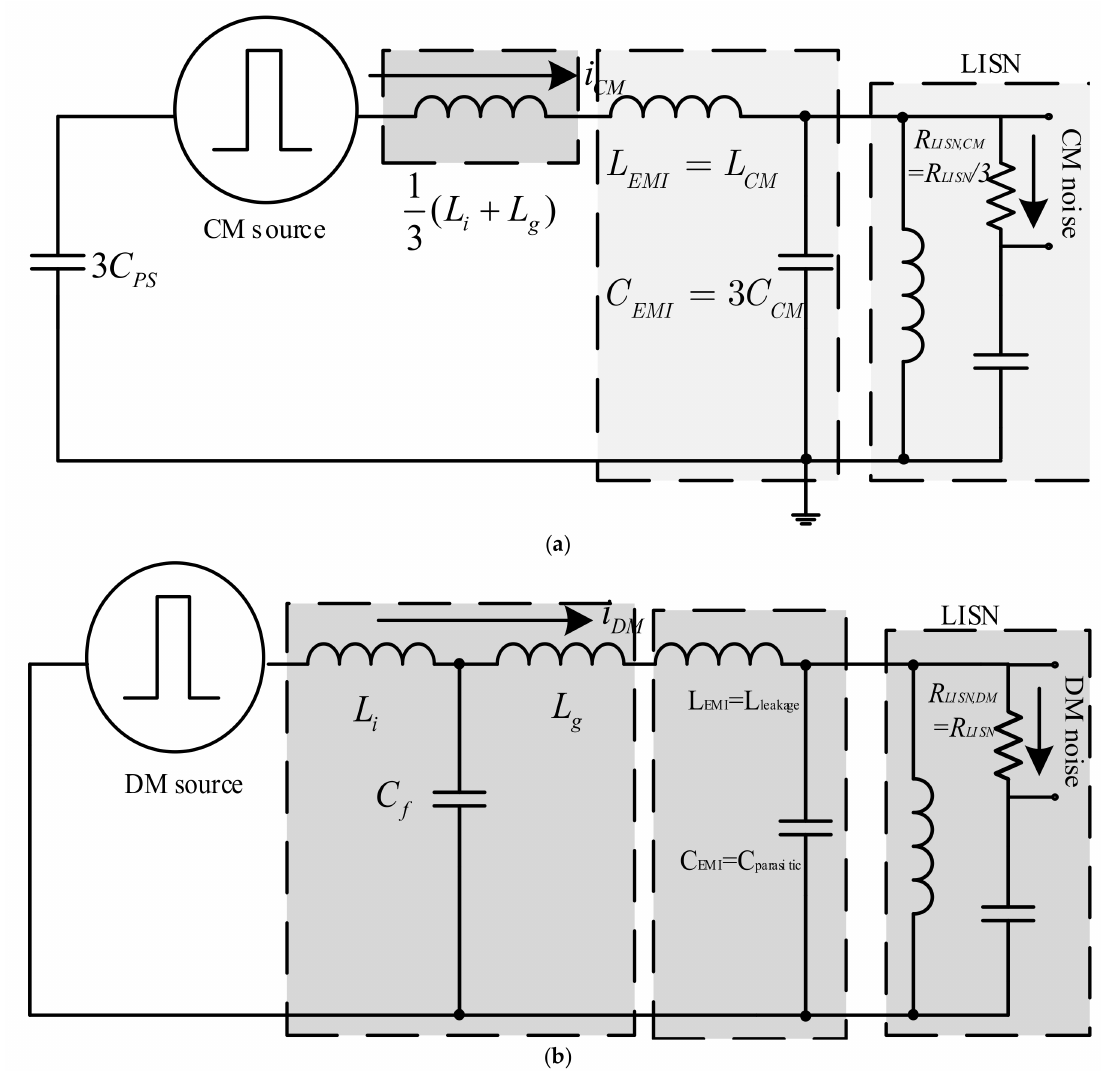
Figure 8. Electromagnetic interference (EMI) noise model: ( a ) equivalent common mode (CM) noise model and ( b ) equivalent differential mode (DM) noise